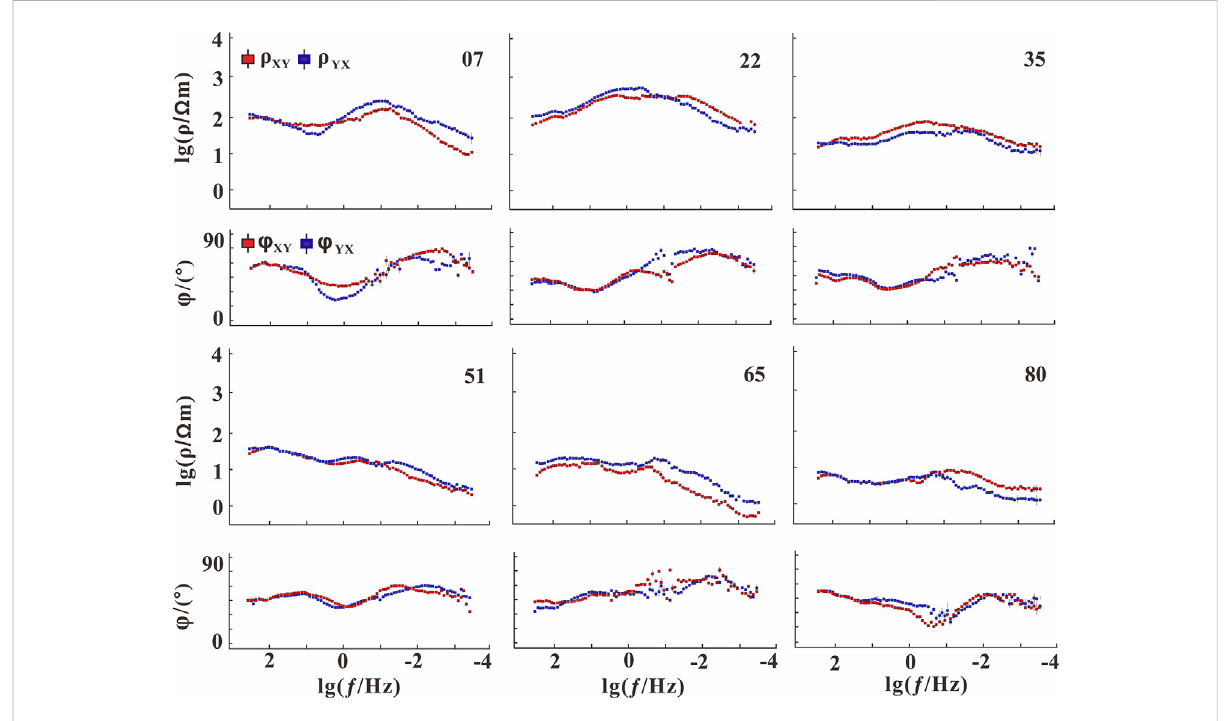
FIGURE 2 Apparent resistivity and phase curves for typical MT stations along the pro fi